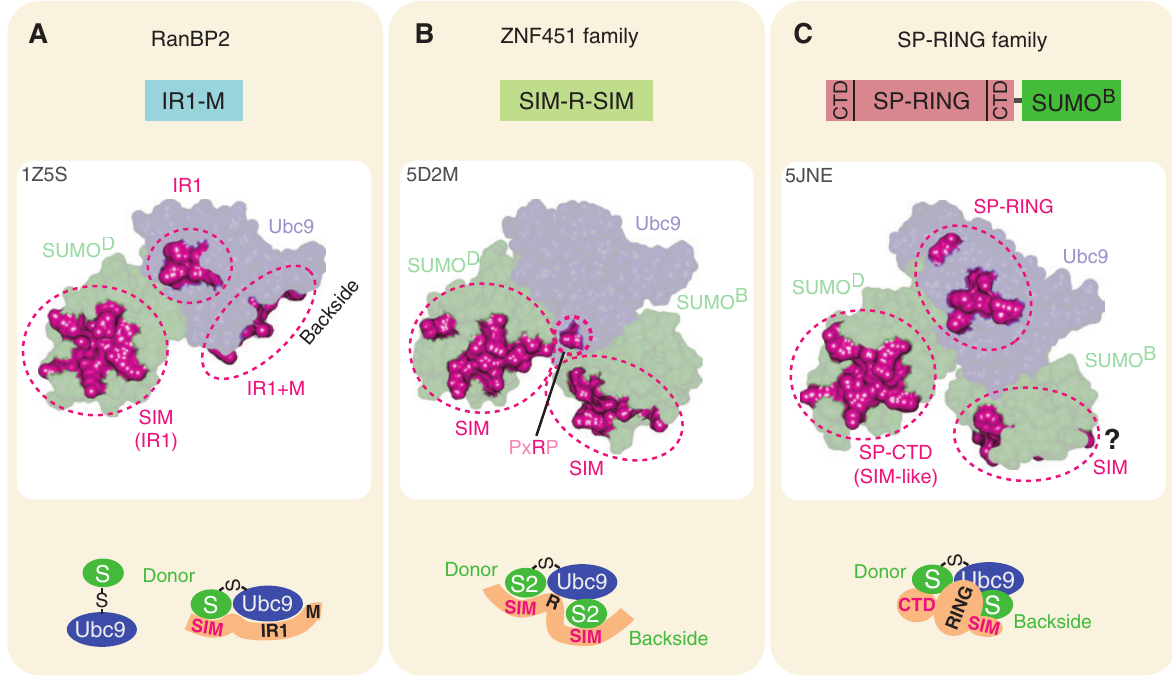
Figure 6: SUMO E3